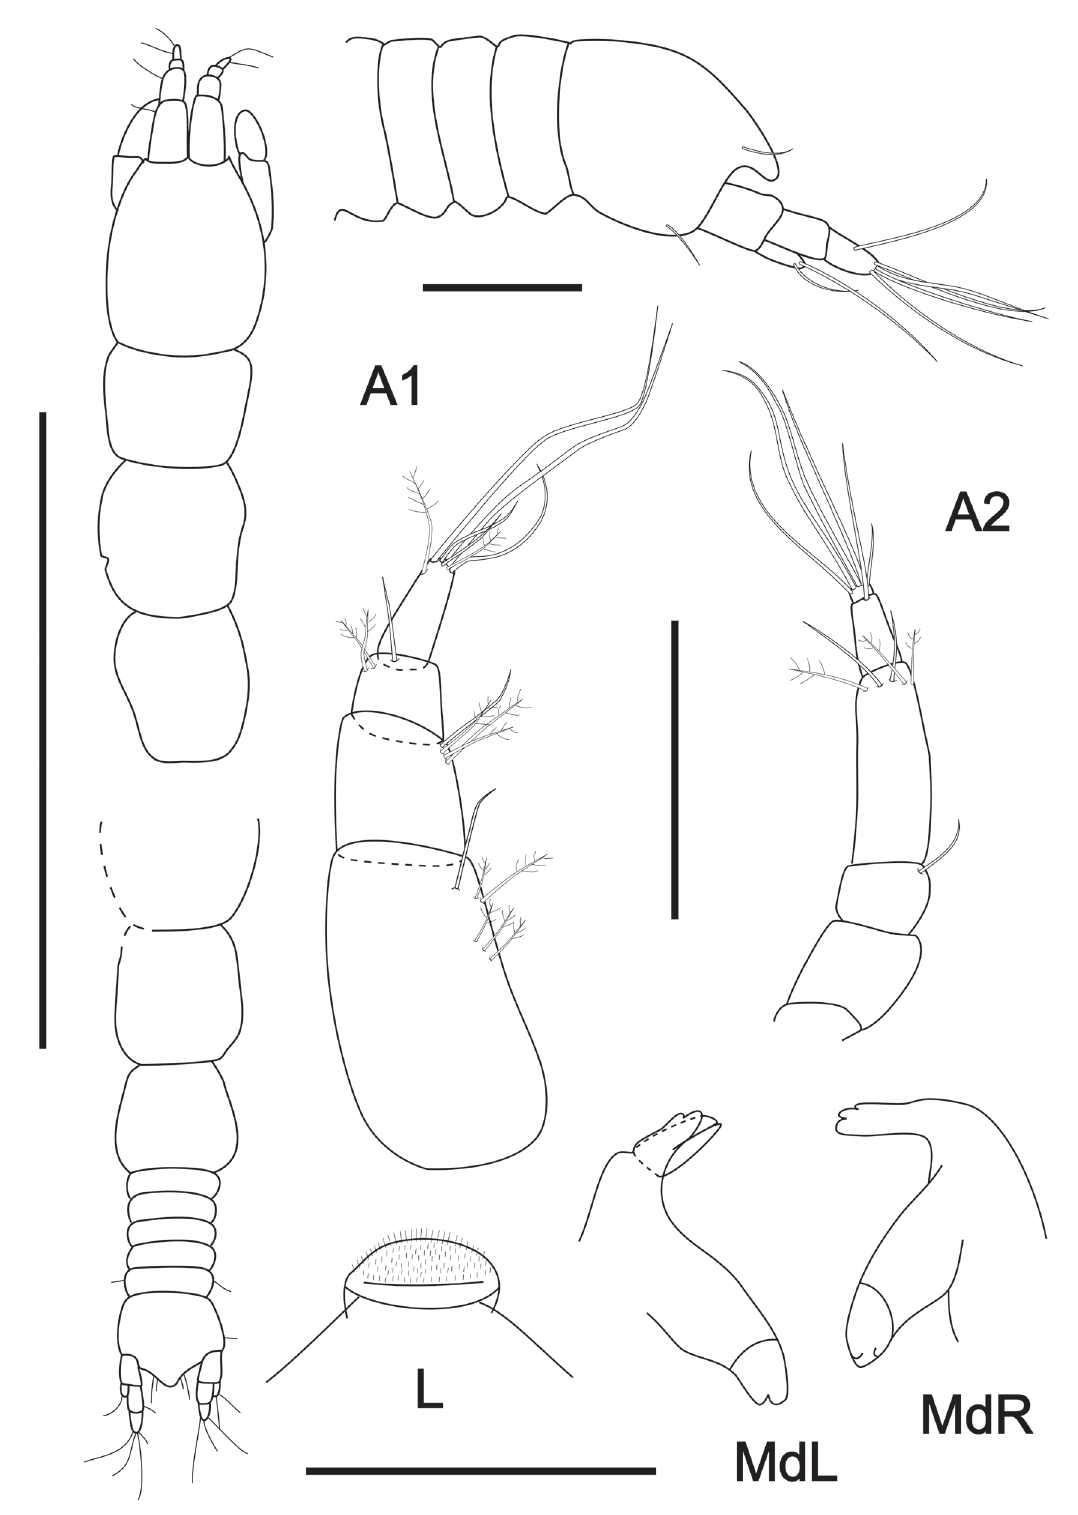
Fig. 4. Macrinella lavradoae sp. nov., holotype, ♀ (MNRJ 24445), length 1.9 mm, body in dorsal view. Scale bar = 1.0 mm. Pleon in lateral view. Abbreviations: A1 = antennules; A2 = antenna; L = labrum; MdL = left mandible; MdR = right mandible. Scale bars = 0.1